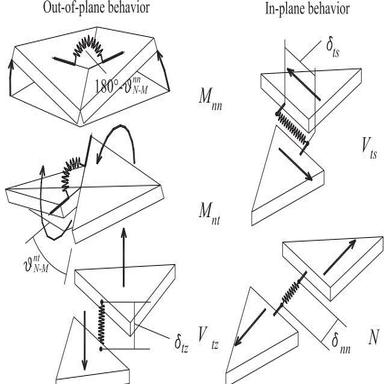
In- and out-of-plane behavior of the inelastic interfaces in the RBS approach.